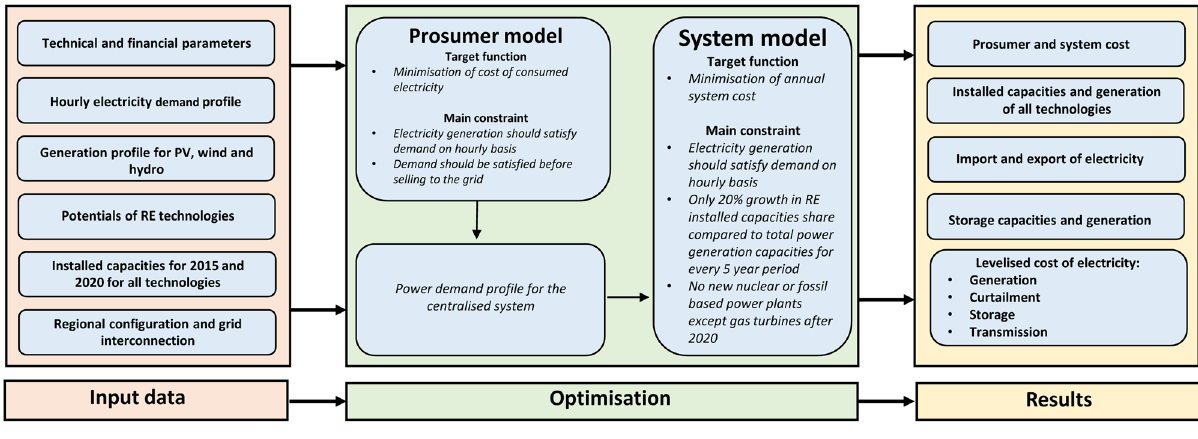
fi rst,theprosumertargetfunctionisoptimised,andinthesecondstep,thesystem target function. Different optimised results are obtained as an